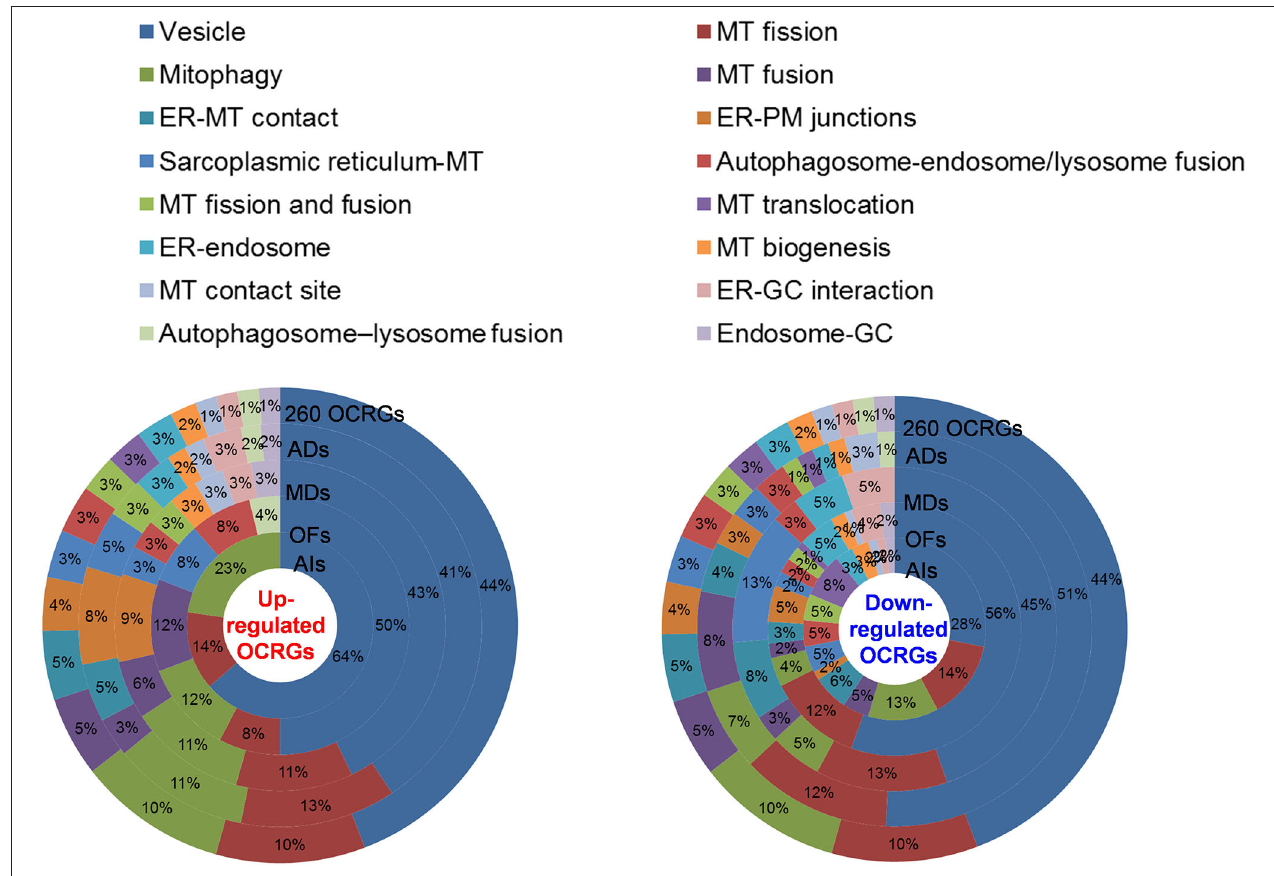
FIGURE 3 | Donut chart shows the different classification/function ratios of upregulated and downregulated OCRGs in acute inflammations (AIs), metabolic diseases (MDs), autoimmune diseases (ADs), and organ failures (OFs). From the center to the outside of the donut chart, the circle represents the ratios of OCRGs in acute inflammations (AIs), organ failures (OFs), metabolic diseases (MD), autoimmune diseases (ADs), and all 260 OCRGs in turn. Groups of upregulated OCRGs in AIs (3) and OFs ( 7) are less than in MDs (12) and OFs (14) (left). In the 21 upregulated genes in AIs, vesicle-related genes account for 64%, and mitophagy and mitochondrial (MT) fission genes account for 14 and 23%, respectively. In the 26 upregulated genes in OFs, the top 3 high-number genes are vesicle- (50%), mitophagy- (12%), and MT fusion-related (12%) OCRGs. In the 34 upregulated genes in MDs, vesicle- (43%), MT fission- (11%), and mitophagy-related (11%) genes are the top 3 genes with high proportion. In the 59 upregulated genes of ADs, vesicle-related genes account for 41%, MT fission genes account for 13%, and mitophagy genes account for 11%. The downregulated OCRGs distributed in AIs, OFs, MDs, and ADs are 15, 15, nine, and 14 groups, respectively (right). In the 58 downregulated genes in AIs, the top 3 high-number genes are vesicle- (28%), MT fission- (14%), and mitophagy-related (13%) genes. In the 99 downregulated genes in OFs, the proportions of vesicle (56%), MT fission (12%), and ER–plasma membrane (PM) junctions (5%) genes are higher than those of others. In the 34 downregulated genes in MDs, the numbers of vesicle (45%), MT fission (13%), and endoplasmic reticulum (ER)–MT contact genes (13%) are higher. In ADs, vesicle (51%), MT fission (12%), and MT fusion genes (8%) are the top 3. These results show that different diseases have different expression patterns of OCRGs and that the classification proportion of upregulated and downregulated genes in the same type of diseases is different, which may explain the different functions of OCRGs in the occurrence and development of diseases. Abbreviations: ER, endoplasmic reticulum; GC, Golgi complex; MT, mitochondria; PM, ER–plasma